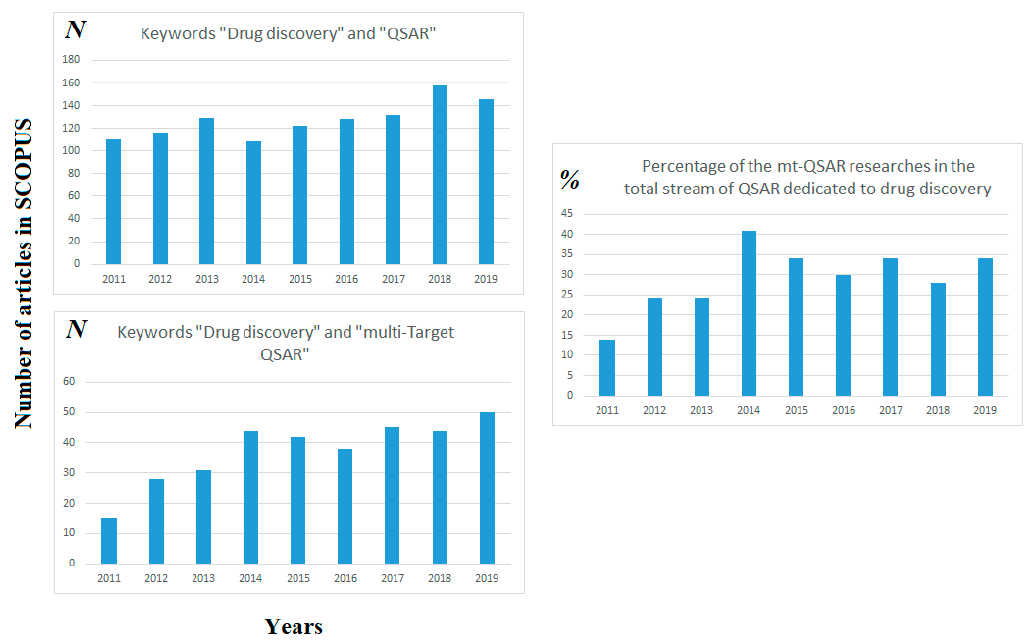
Figure 1. Comparison of frequencies of using quantitative structure–activity relationships (QSAR) and multi-target QSAR (mt-QSAR) in drug discovery researches.